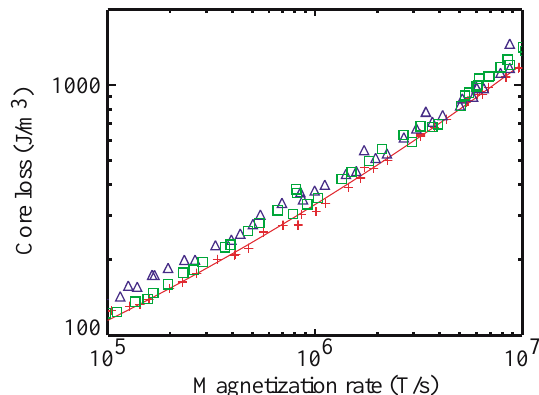
FIG. 14. (Color) Core loss versus magnetization rate for three METGLAS alloys. The data are for the listed flux swings: ( (cid:1) , green, heavy line) MRTI SA1-2 at 2.10 T; ( (cid:3) , blue, dashed line) MRTI 2605 SC-01 at 2.20 T; and ( 1 , red, solid line) MRTI Thin-SA1-2 at 2.10 T.